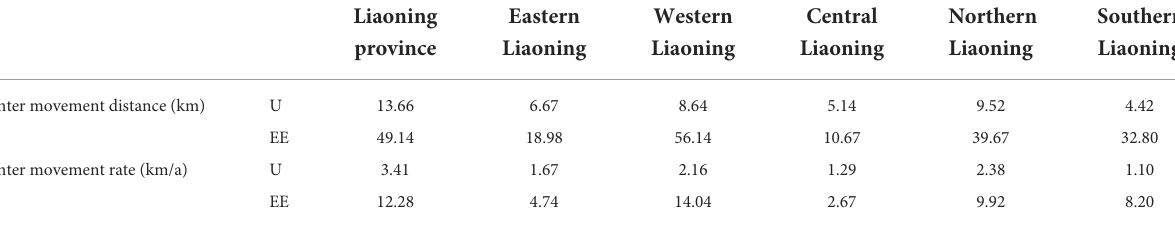
TABLE 3 Movement distance and rate of urbanization (U) and eco-efficiency (EE) of centers of agricultural counties and districts in Liaoning province